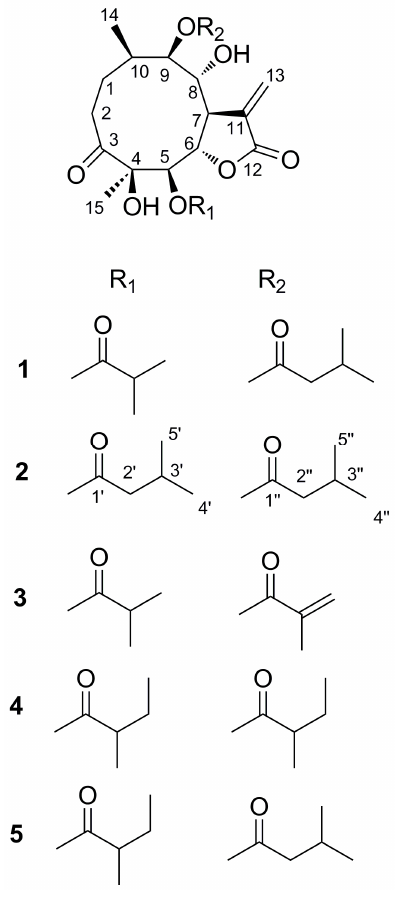
Figure 1. C hemical structures of compounds 1 – 5 . Figure 1. Chemical structures of compounds 1 – 5